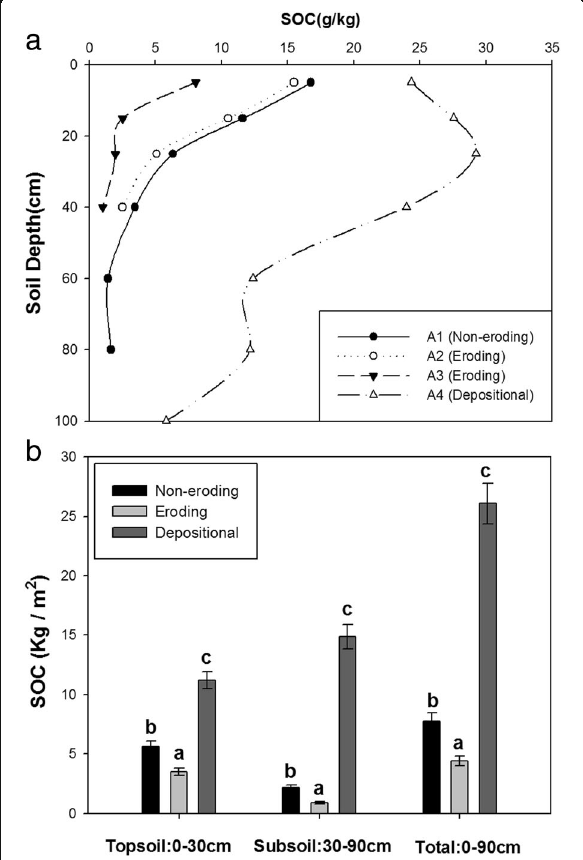
Fig. 2 SOC depth distribution ( a ) and stocks ( b ) as a function of the geomorphic position. Statistical tests for differences between the means of the geomorphic classes have been performed for the entire dataset and for top and subsoil samples separately. The same letter indicates no significant difference between the geomorphic positions ( p <